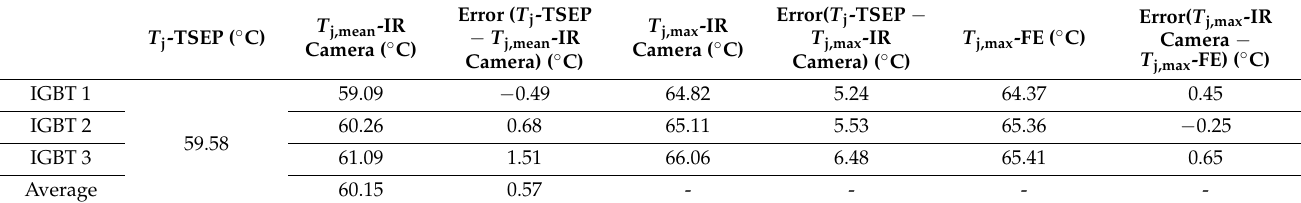
Table 5. Junction temperature measurement